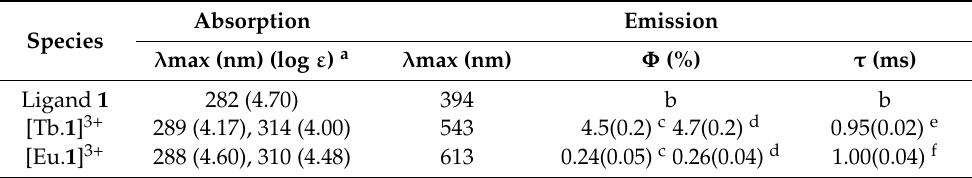
Table 1. Photophysical properties of ligand 1 and lanthanide complexes in CH 3 CN at room tem- perature.